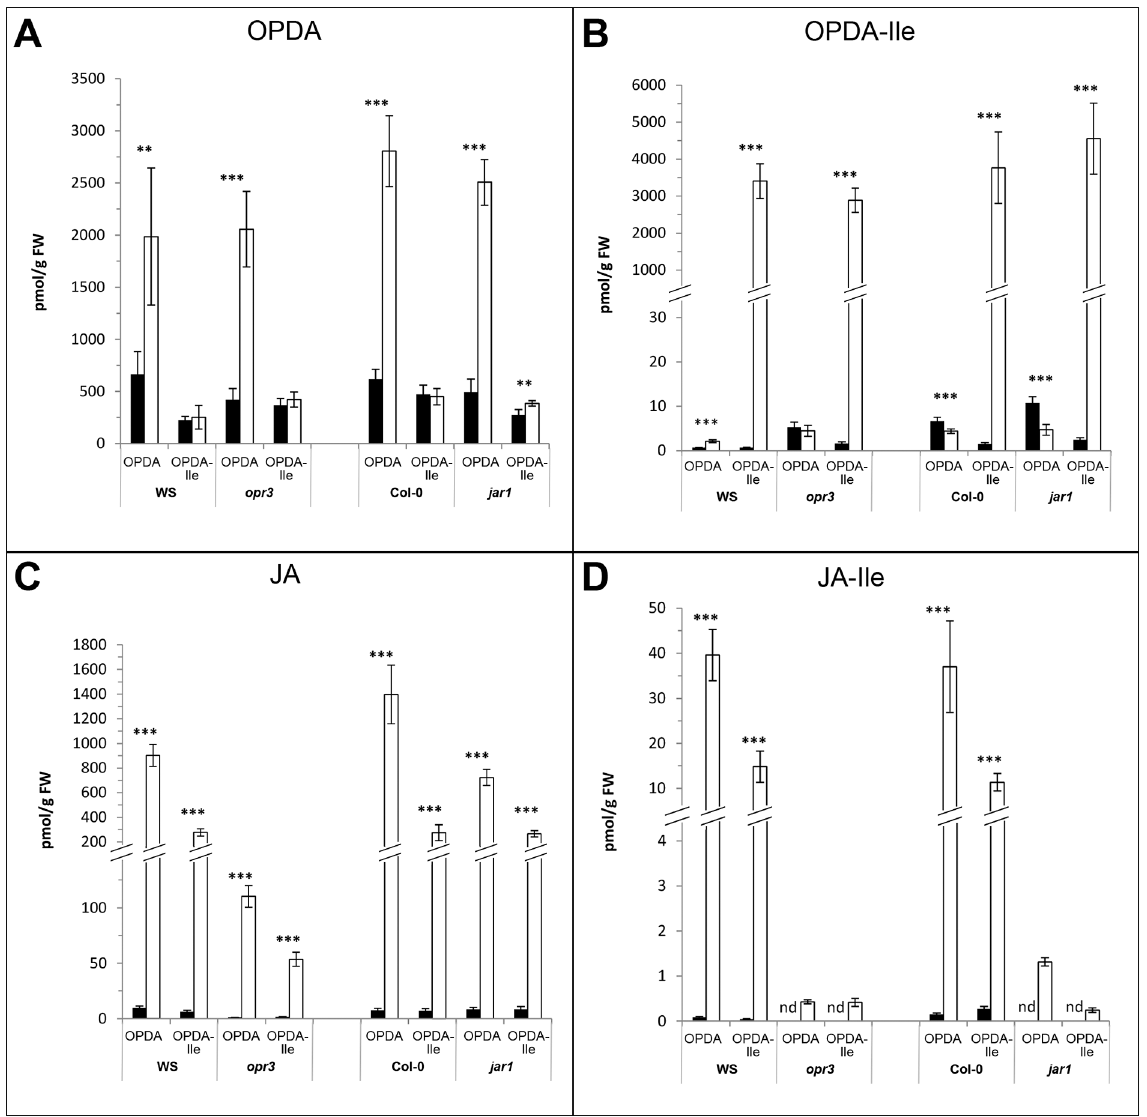
Fig 2. Levels of OPDA (A), OPDA-Ile (B), JA (C) and JA-Ile (D) in seedlings of Arabidopsis thaliana WS, opr3 , Col-0 and jar1 after treatment with OPDA or OPDA-Ile. 10-days-old seedlings grown in liquid culture were treated with 30 μ M OPDA or 30 μ M OPDA-Ile for 30 min (white bars). Two independent controls (black bars) were performed by treatment with bi-distilled H 2 O containing 0.87% [v/v] and 0.56% [v/v] acetonitrile, respectively. Compounds were quantified according to [24]. Each value is represented by the mean of five independent biological replicates ± SD. Treatments and controls were pairwise compared by the Student ’ s t-test, * p (cid:1) 0.05, ** p (cid:1) 0.01, *** p (cid:1)